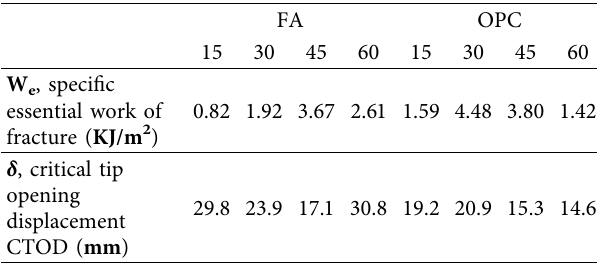
Table 4: Specific essential work and critical tip opening dis- placement for mixes with FA and OPC at 15 o C and speed rate of 25mm/min.